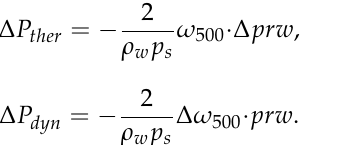
Therefore, Equations (4) and (5) can be estimated by the product of ω 500 and prw :